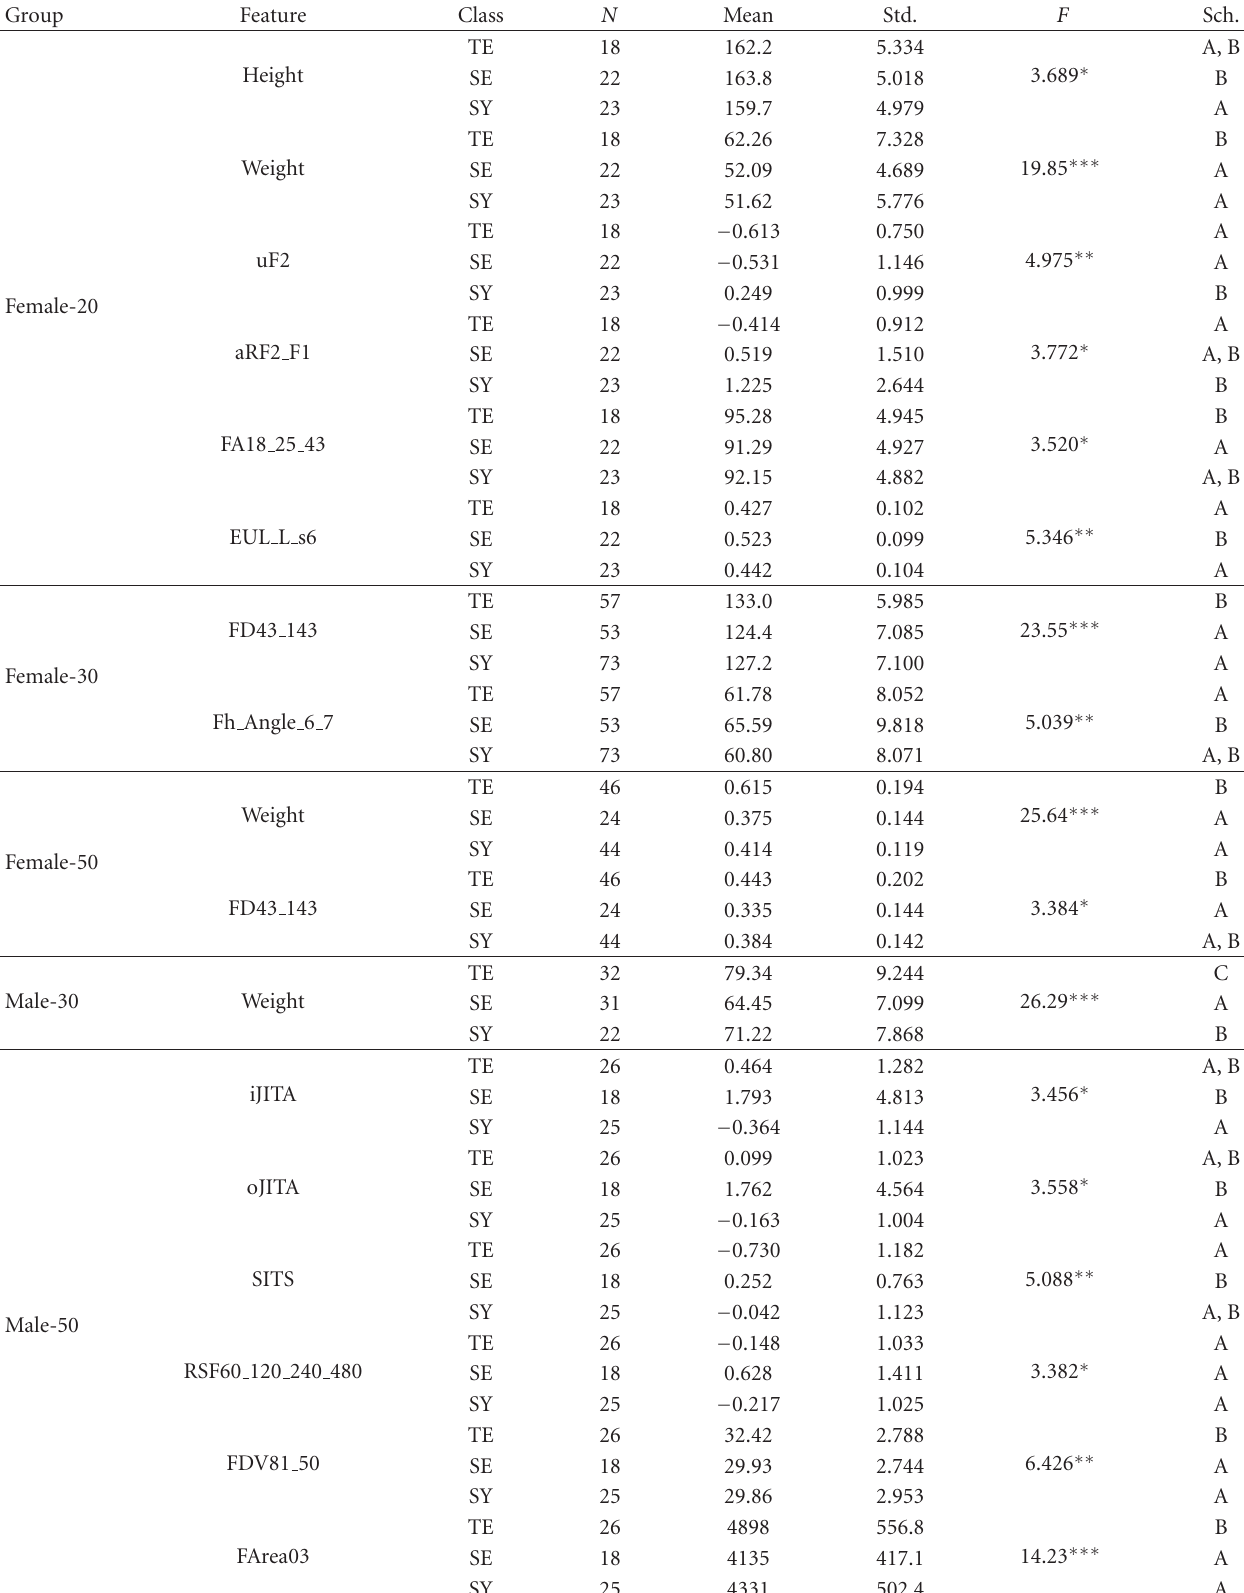
Table 4: Statistical analysis by the one-way ANOVA test and the post-hoc Sche ff e’s test.